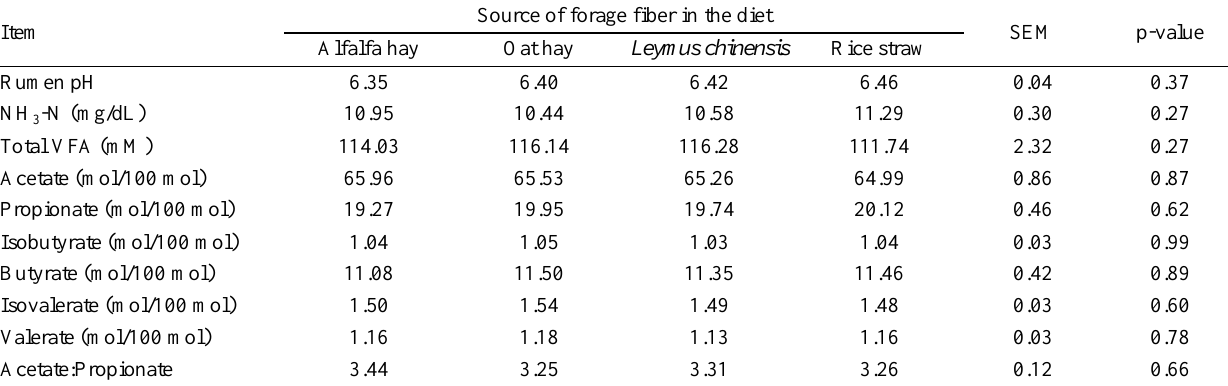
Table 3. Effects of alfalfa hay, oat hay, Leymus chinensis , and rice straw as dietary forage sources on ruminal fermentation Item